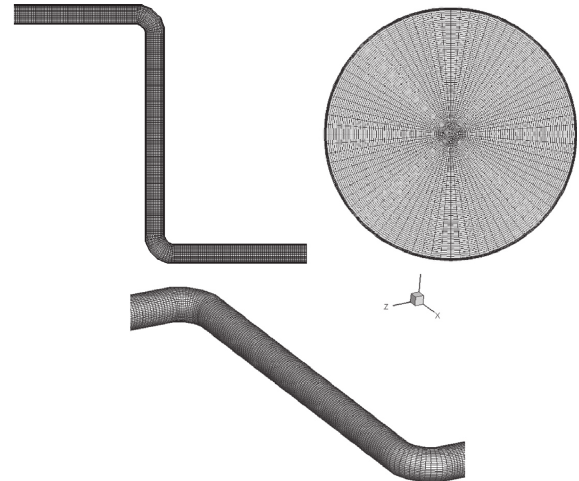
Figure 2: Computational